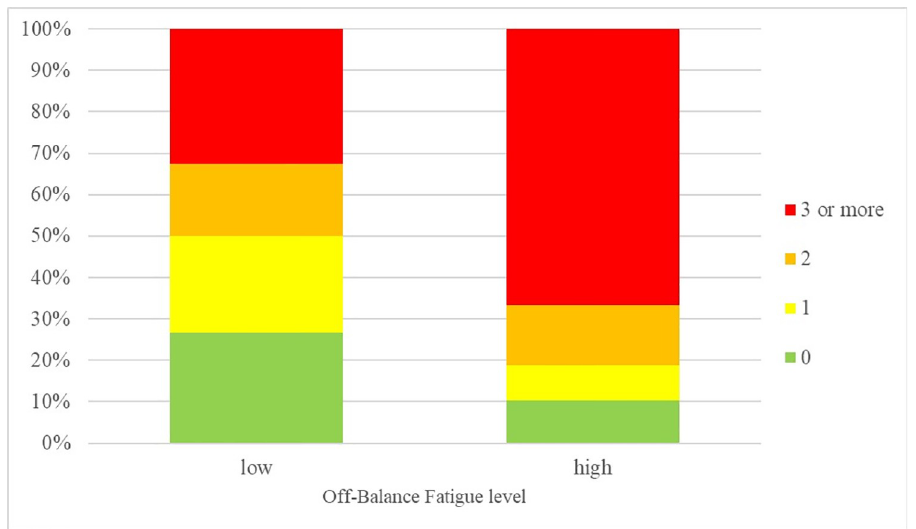
Fig 2. Number of psychosomatic symptoms per Virtual Relations fatigue